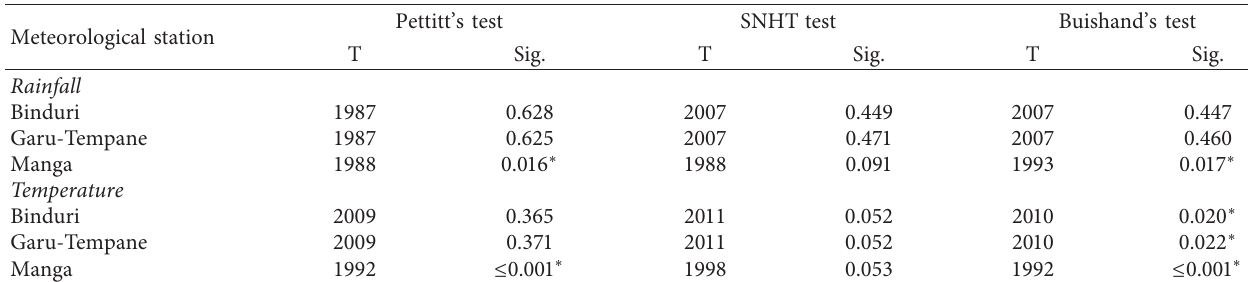
Figure 3: Homogeneity test showing change point Tin annual rainfall and temperature. (a) Binduri gauge station. (b) Garu-Tempane gauge station. (c) Manga gauge Table 4: Homogeneity test statistics.